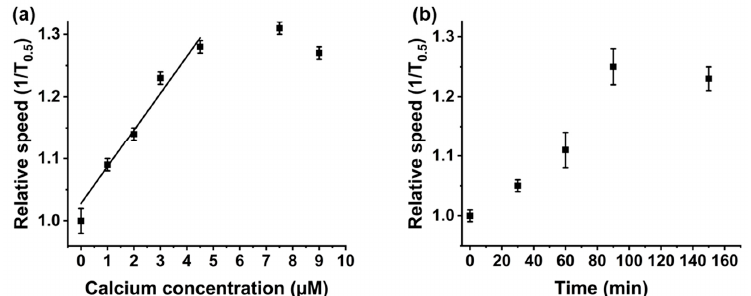
Figure 4. ( a ) Relative particle speeds normalised to blank DNAzyme functionalised particles, versus varying amounts of Ca 2+ ions added from 1–9 μ M, measured at 30 min. ( b ) 0.3 μ M Ca 2+ ions added, incubated from 30 to 150 min. Samples were run in triplicate, and between 250 and 300 particles were measured for each sample. Error bars are one standard deviation from the mean. To demonstrate that the selectivity of our assay was dependent upon the Ca 2+ binding to the DNAzyme, we incubated our DNAzyme functionalised particles with different metal ions. As the previous study had reported some binding with Mg 2+ [55], Mg 2+ was added at 3 μ M and incubated